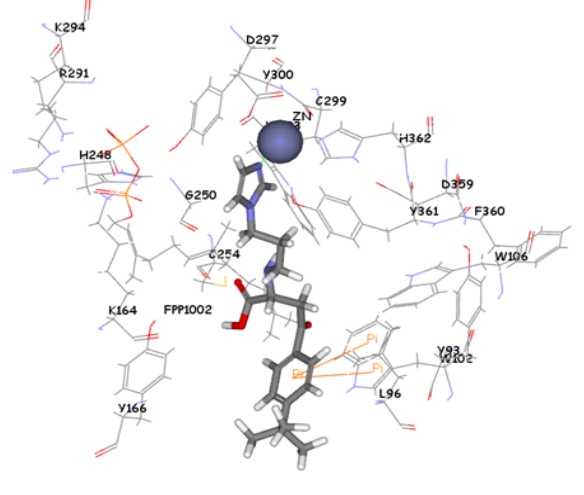
Figure 10. Molecular docking result of ZINC39323901 displayed in stick format, zinc atom CPK and active site amino acids presented as line